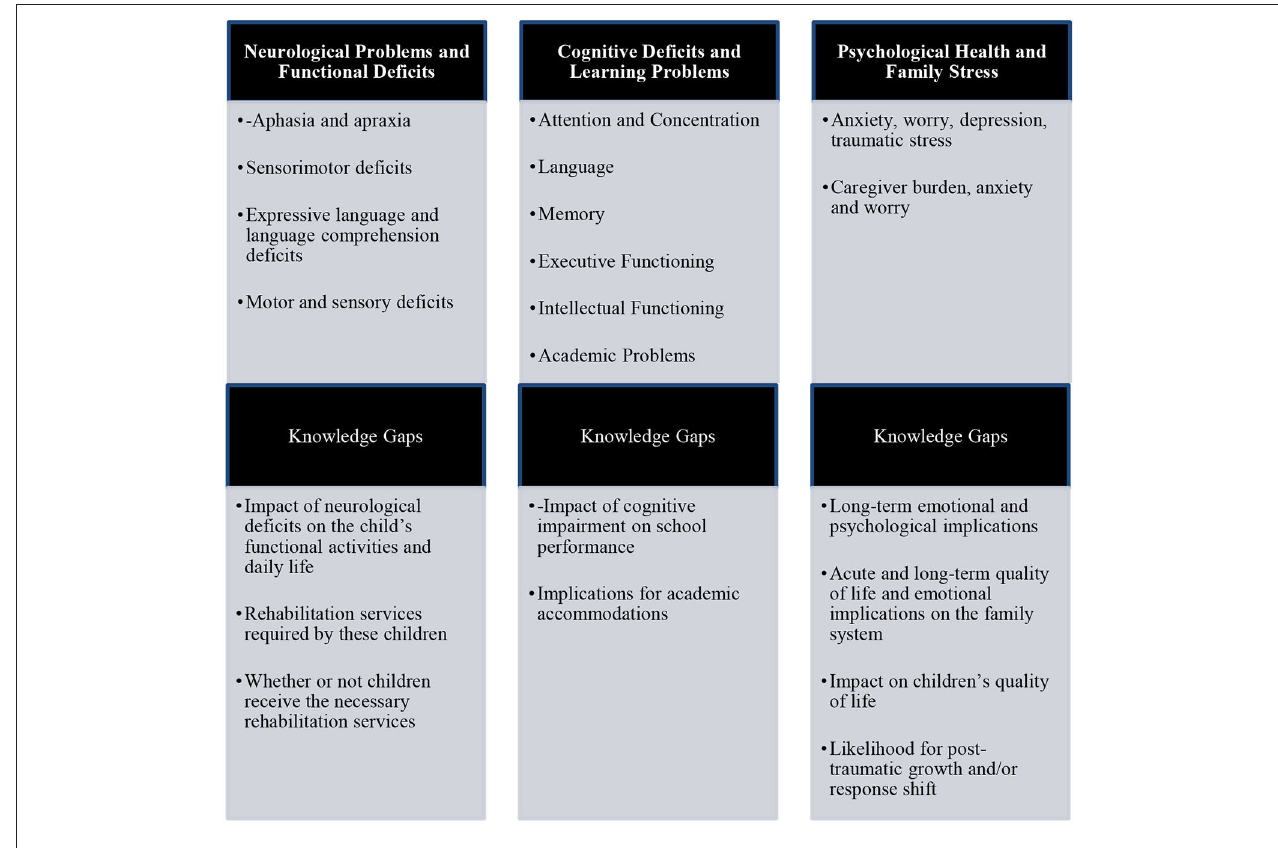
FIGURE 5 | Treatment and rehabilitation needs of children following cardiac arrest. Post-traumatic growth can be conceptualized as experiencing positive outcomes as a result of struggling with highly challenging life crises (41). Response shift (42) refers to a psychosocial process whereby people change their evaluation of quality of life in response to changes in their internal standards, values, and conceptualization of quality of life when they are faced with a life threatening or chronic disease.